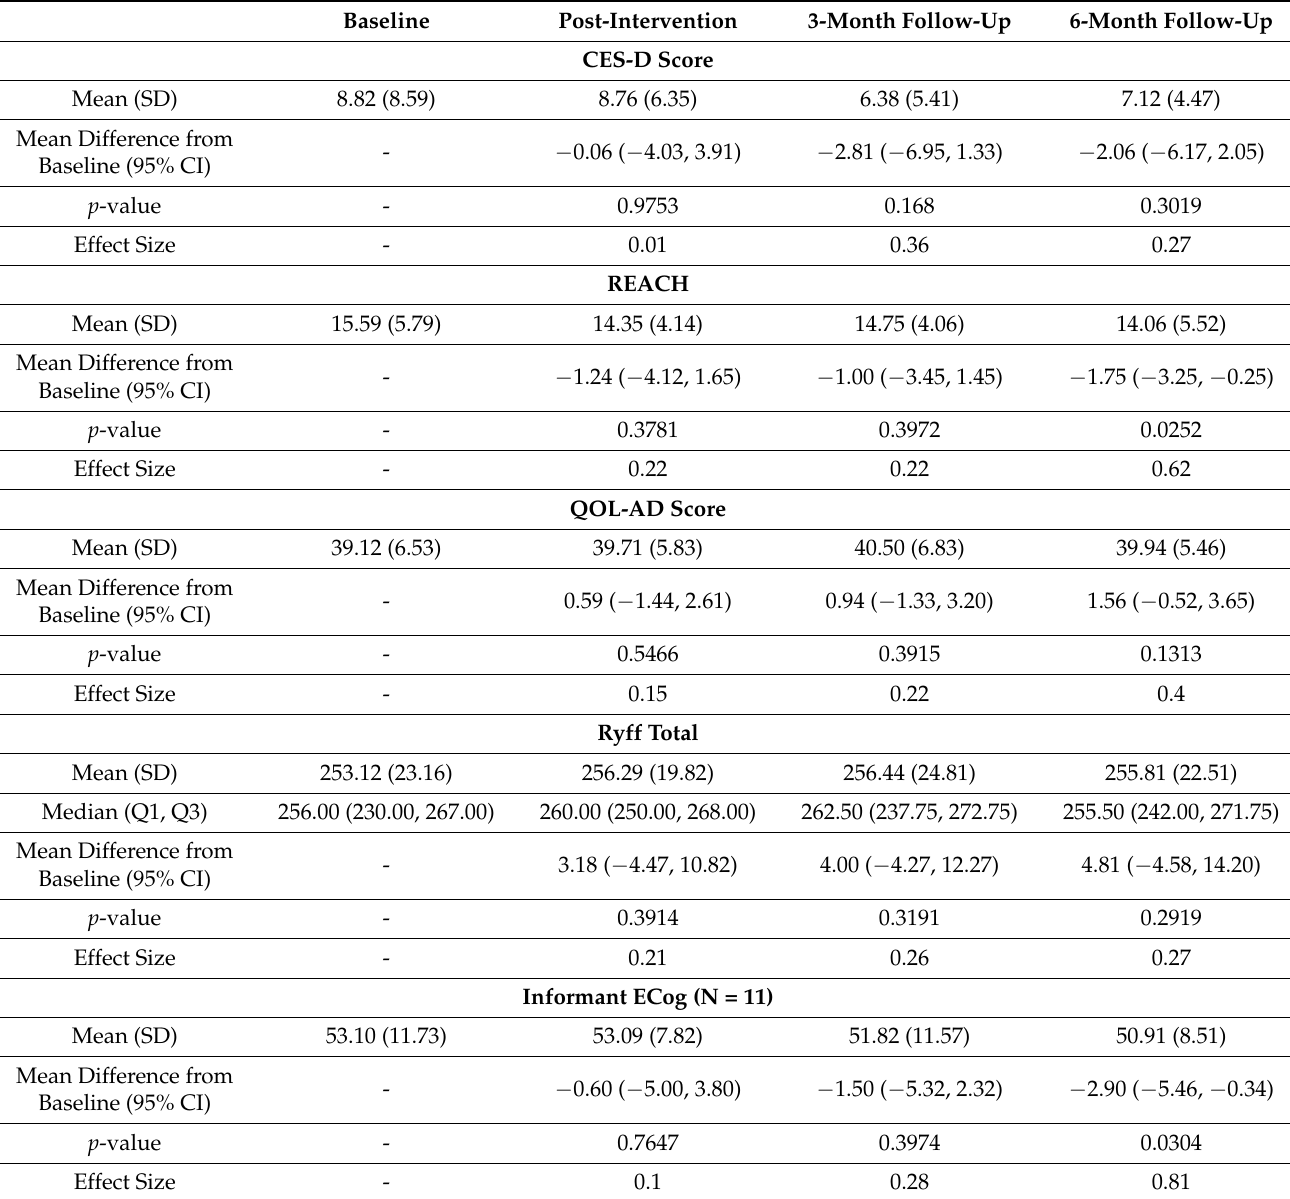
Table 3. Self and informant-reported secondary outcomes at all timepoints. All active participants combined (N = 17).